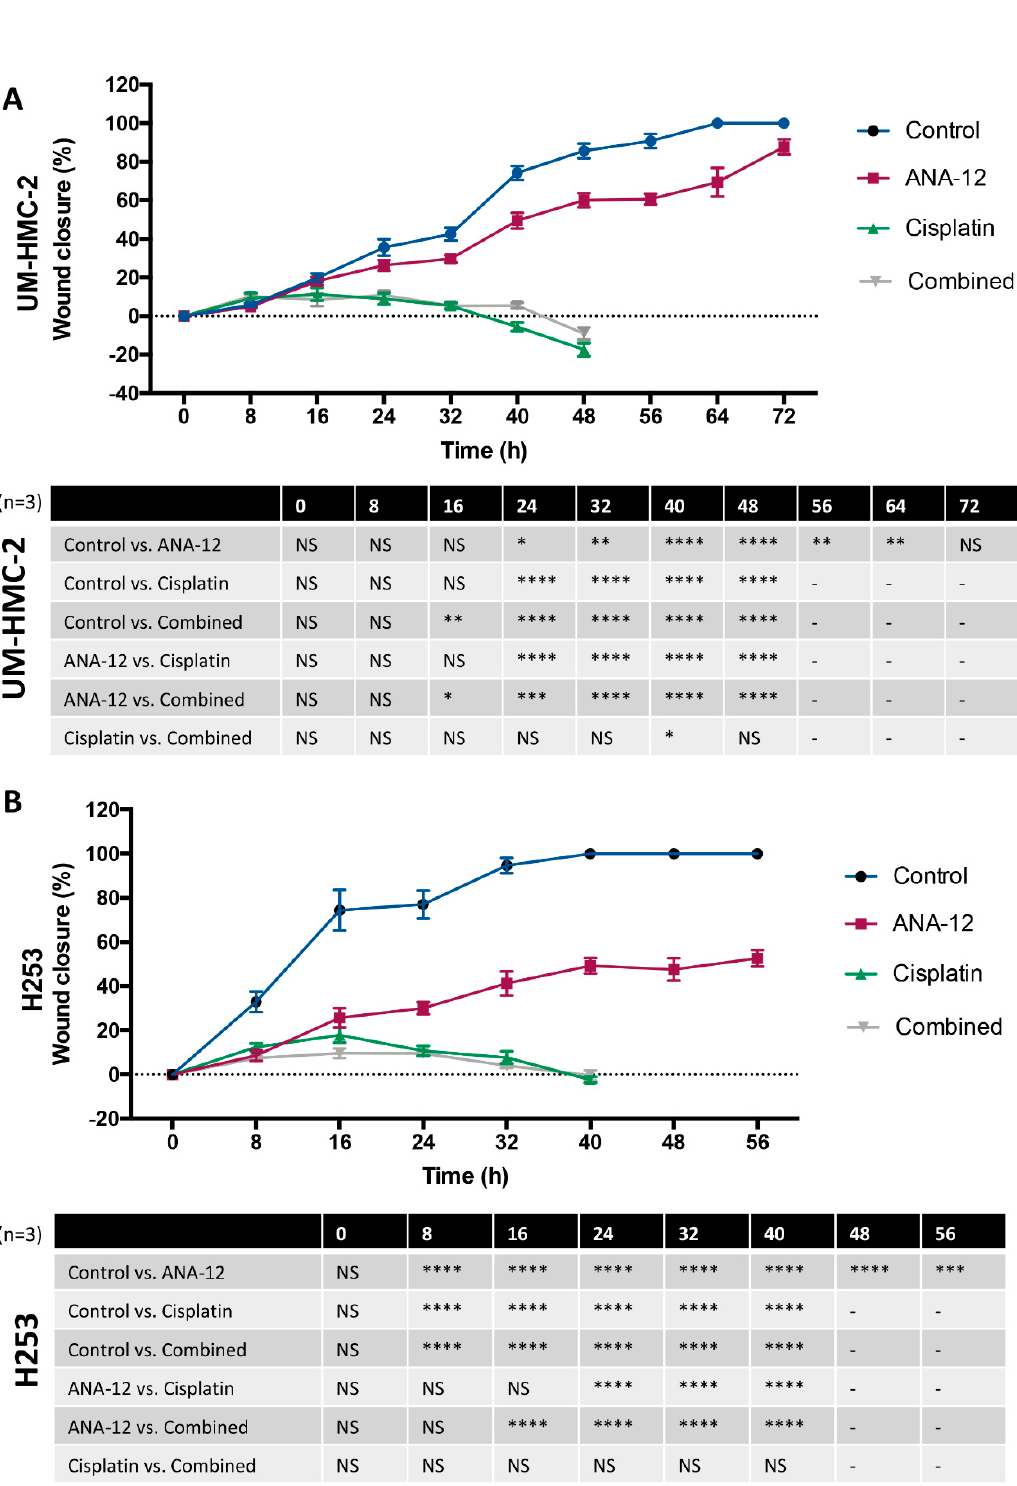
Figure 3. ( A ) UM-HMC-2 wound closure following ANA-12, Cisplatin and combined treatment. Note that the combined treatment presented the most promising results to delay wound closure in this cell line. ( B ) H253 wound closure following ANA-12, Cisplatin and combined treatment. Note that Cisplatin and the combined treatment results were similar and ANA-12 effects occurred earlier and in a greater magnitude, compared to UM-HMC-2 (* p < 0.05; ** p < 0.01; *** p < 0.001; **** p < 0.0001 and NS p > 0.05).